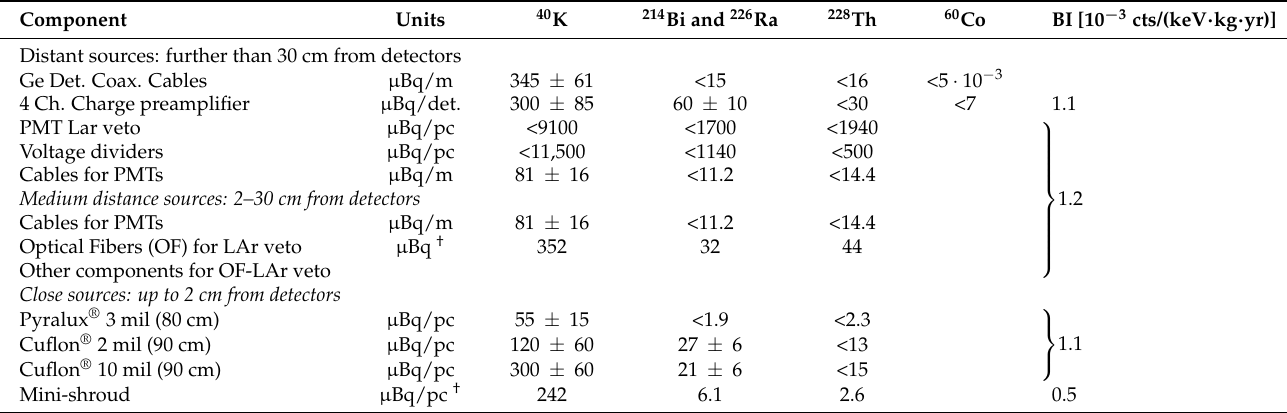
Table 4. Gamma/ICPMS screening results for the new materials and parts deployed in Phase II. Upper limits are 90% C.L. while uncertaintes are 1 σ values. The estimated contributions to the BI at Q ββ are for the whole functional units (all the FE boards, the two LAr-veto detectors, all the FE flex contacts, all the mini-shrouds) after anti-coincidence but before LAr and PSD